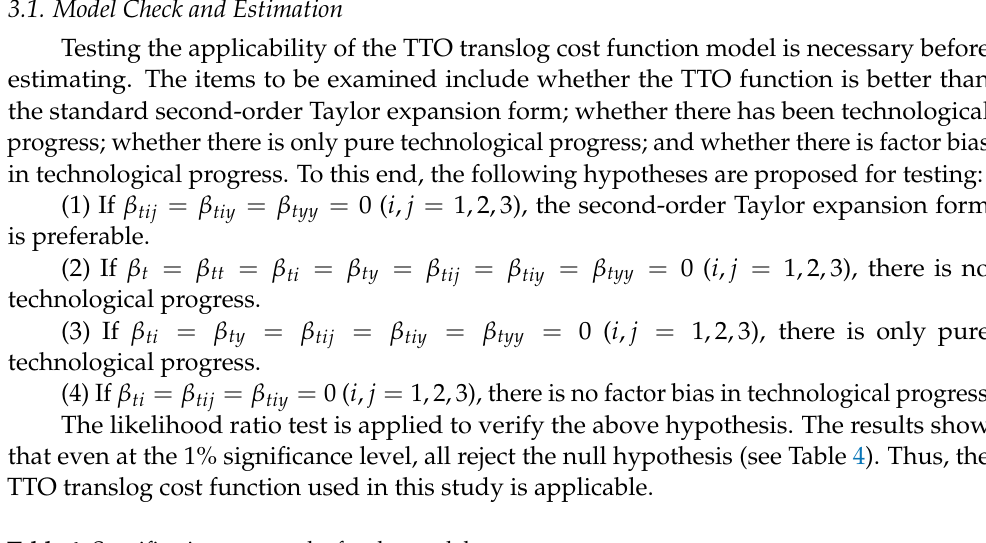
Table 4. Specification test results for the